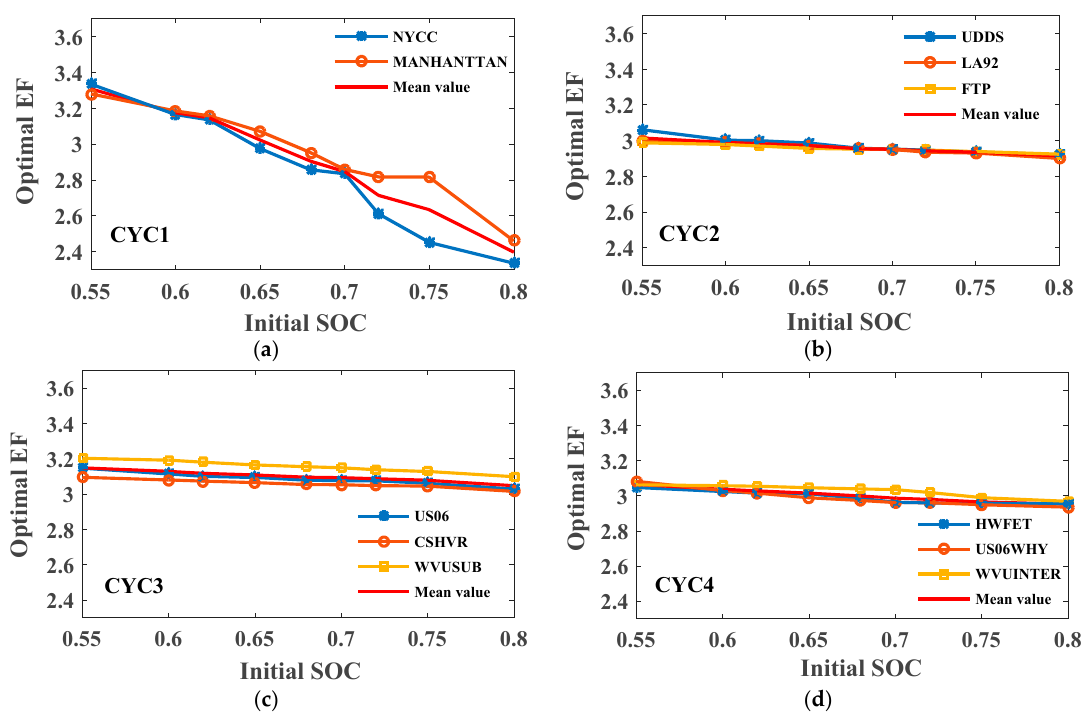
Figure 7. Initial SOC versus optimal equivalent factor under different driving patterns. ( a ) CYC1, ( b ) CYC2, ( c ) CYC3, ( d ) CYC4.